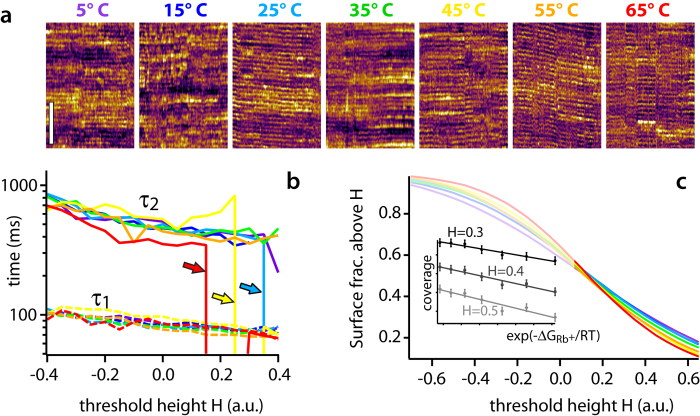
Influence of temperature on the surface kinetics of mica in a solution containing Rb+ ions.As the temperature increases, the apparent roughness of mica tends to decrease and the surface becomes smoother, except for possible Rb+ adsorption events (a). The height of all the kinetic data has been renormalized to allow direct comparison (see also supplementary Figs S11 and S12 for details). The characteristic timescales τ1 and τ2 calculated from the kinetic traces show little dependence on temperature for a wide range of height thresholds H (b). Generally, the timescales tend to decrease with increasing H since higher thresholds emphasize faster adsorbing/desorbing Rb+ ions over the slower dynamics of hydration water and H3O+ in the statistics. For the higher temperatures τ2 can decrease rapidly past H~0.1 (arrows), often converging to values close to τ1 due to the smoother mica surface that makes distinguishing between the two timescales difficult. The decrease of apparent surface roughness can be quantified by plotting the surface fraction above a given height H for each temperature (c). Since the height has been normalized, all the curves in (c) intersect in a same point near H~0.1. This ‘isosbestic’ point is not at H = 0 due the adsorbed ions and water molecules at the interface that create an asymmetry in the height distributions (see Fig. S12). The region of the curves >H~0.1 reflect the height of the hydration water and adsorbed Rb+ ions in (a). As the temperature increases, the surface fraction decreases more rapidly with H, following an Arrhenius-type behaviour (Fig. S12). The scale bar is 5 nm in (a) and the kinetic sequences represent 10 s for each temperature (see also Figs S10, 11), and the analysis (b,c) represents more than 30 min × site.